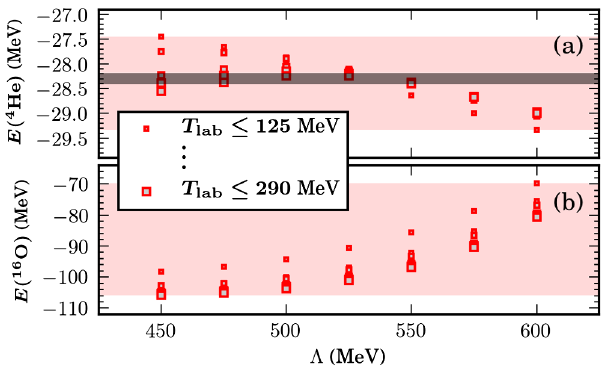
FIG. 11. Binding-energy predictions for (a) 4 He and (b) 16 O with the different reoptimizations of NNLOsim. On the x axis is the employed cutoff Λ . Vertically aligned red markers correspond to different T max for the NN scattering data used Lab in the optimization. The experimental binding energies are E ð 4 He Þ ≈ − 28 . 30 MeV, represented by a gray band in panel (a), and E ð 16 O Þ ≈ − 127 . 6 MeV [98]. Statistical error bars on the theoretical results are smaller than the marker size on this energy